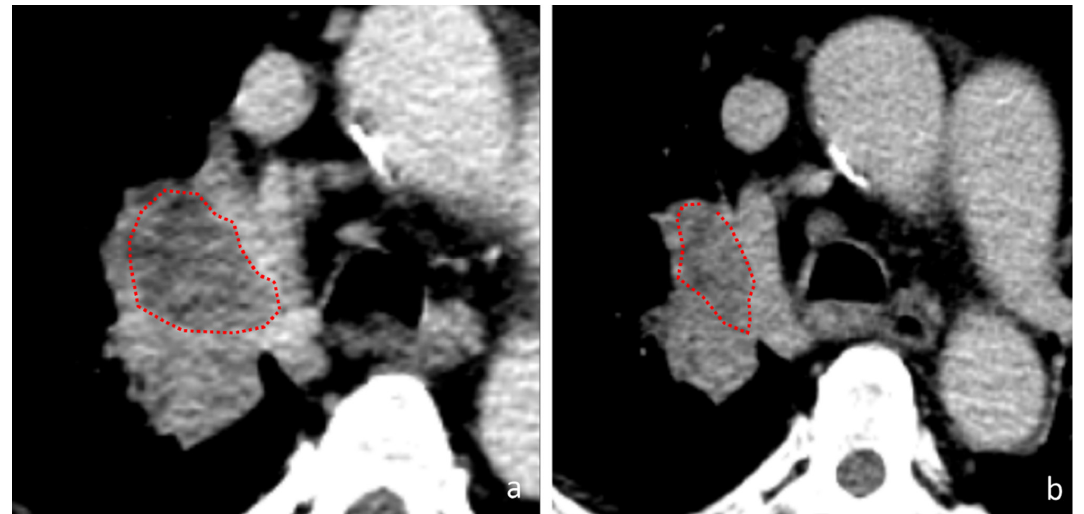
Figure 4. A tumor in the right pulmonary hilum. ( a ) baseline CT-scan ( b ) first assessment CT-scan. During follow-up, the tumoral mass shrunk a variation consistent with PR. At the first re-evaluation the central hypodense area reduced (red dotted circles); this tumor presented a ∆-LALGLE of 1.487953173, which consists of a reduction of 149% of the low attenuation area.